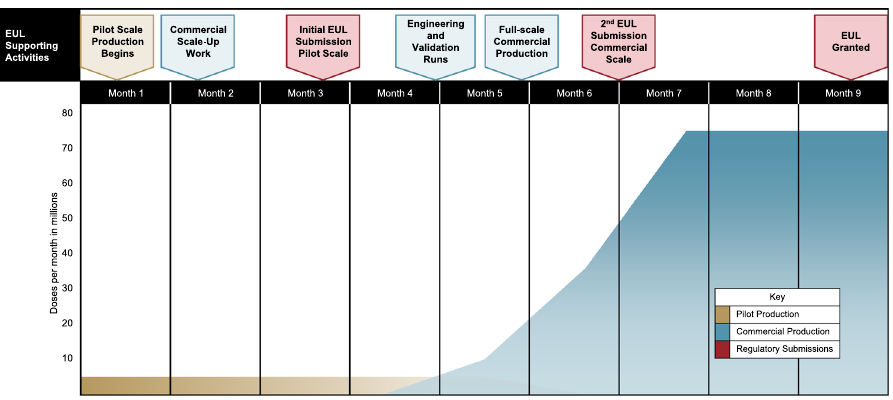
Fig. 2 Example of vaccine production for EUL — concurrent activities needed for pilot and commercial facility scale-up and regulatory submissions. Assumptions in this scenario include: rolling EUL submission is allowed, and that pilot-scale process development and engineering and validation runs completed prior to month 1.